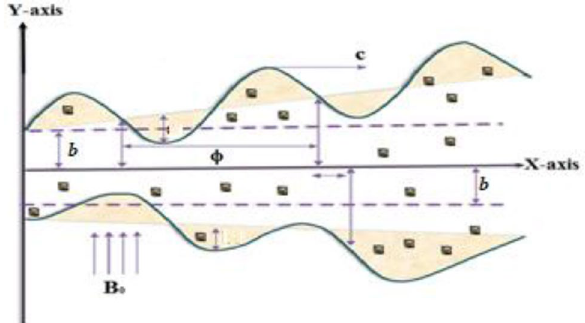
Figure 1. Physical flow